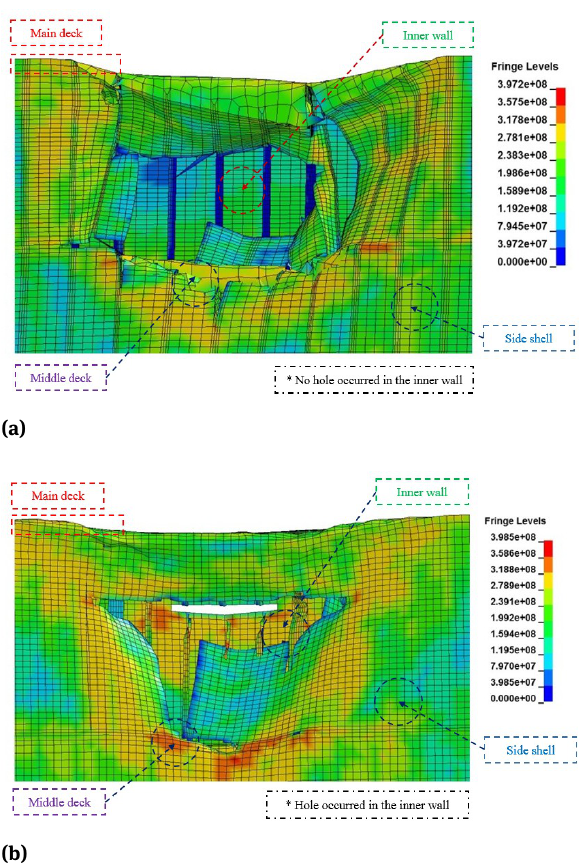
Figure 6: Damage on double hull structure: (a) width 3.5 m and (b) width 1.5 m.